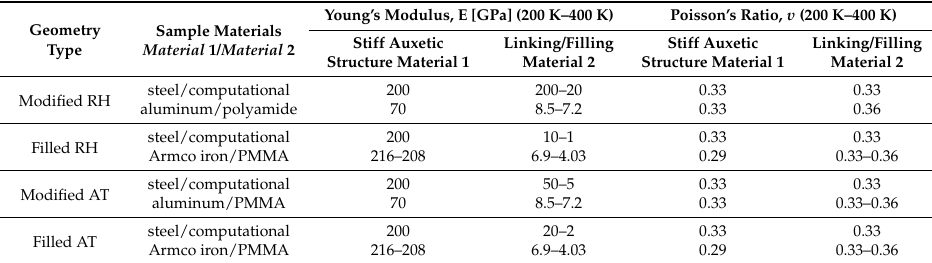
Table 1. Basic characteristics of materials used in selected structures.